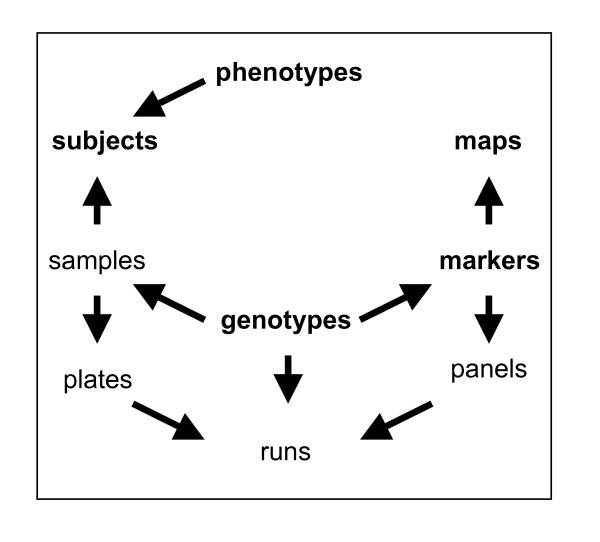
Conceptual view of a genetic mapping experiment in IGS. The arrows represent the direction of work that takes place in the experiment. For example, phenotypes are collected on subjects, genotypes from samples that are taken from subjects.